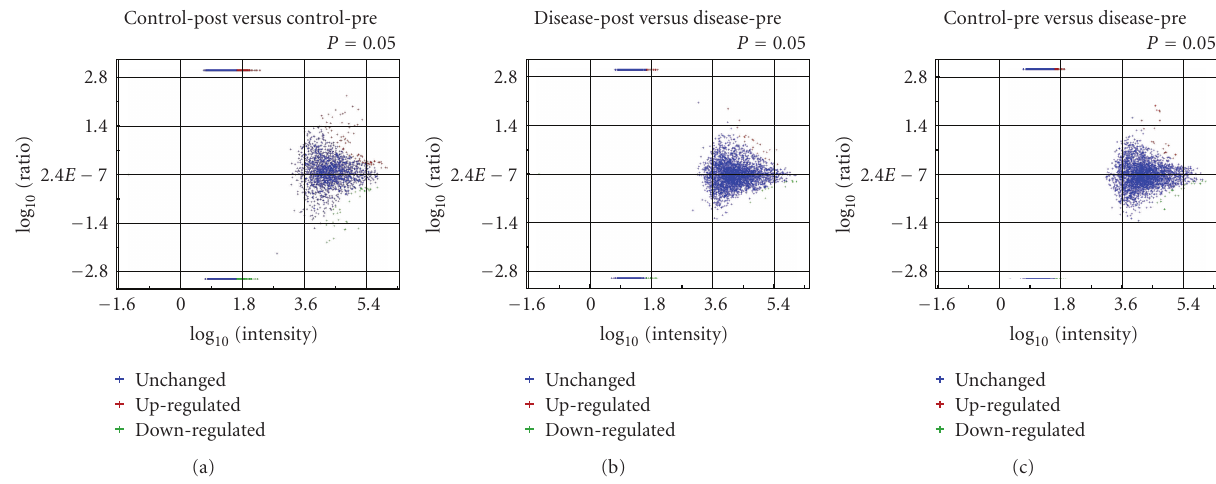
Figure 10: Categorization of upregulated and downregulated features for the ratio data as a function of average intensity for (a) control-post to control-pre, (b) Disease-post to disease-pre, and (c) control-pre to disease-pre.